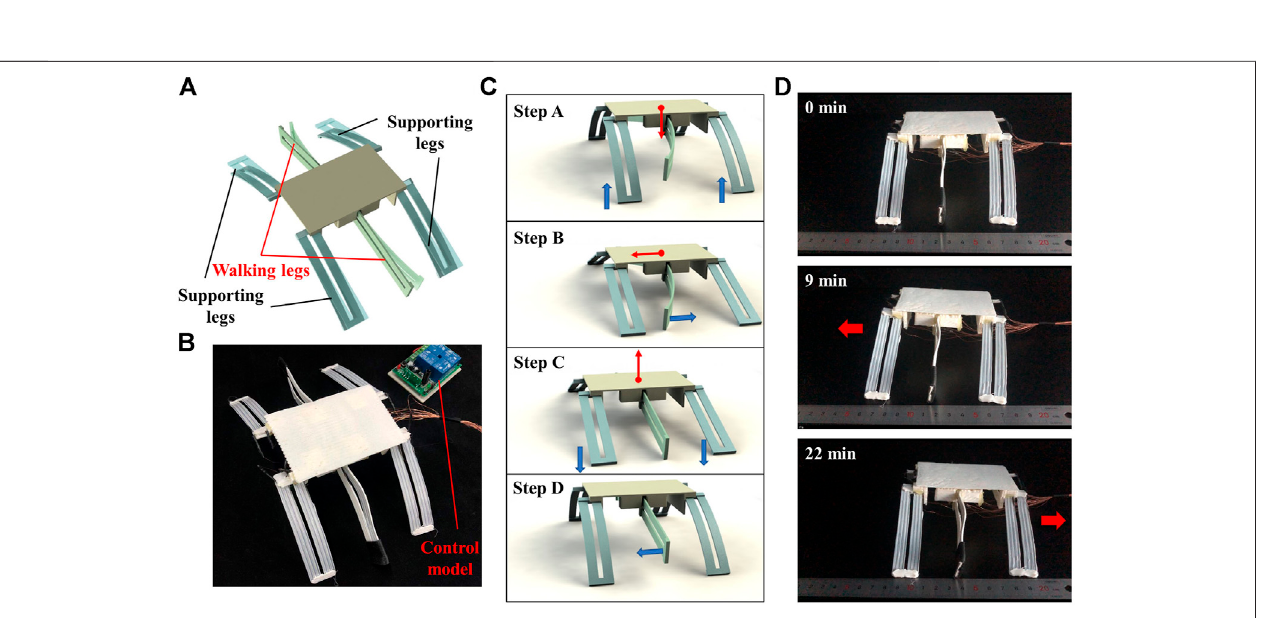
Frontiers in Materials |